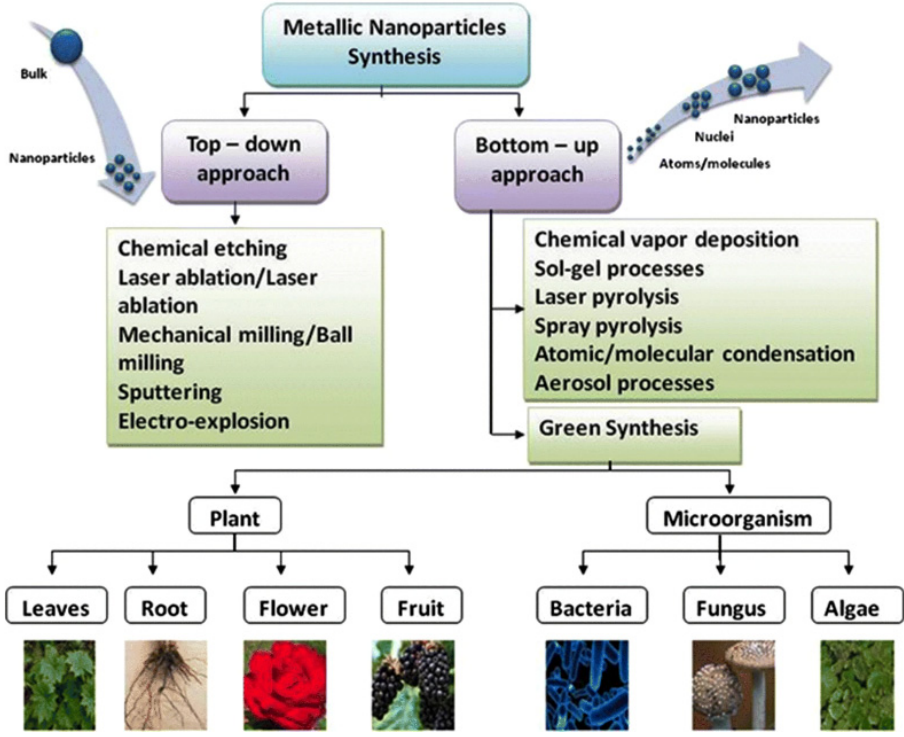
Figure 1. Example of the use of various approaches and biological objects to obtain metal nanopar- ticles. Demonstration of various synthesis methods for the metal nanoparticles [5] The materials are licensed under http://creativecommons.org/licenses/by/4.0/ (accessed on 28 November